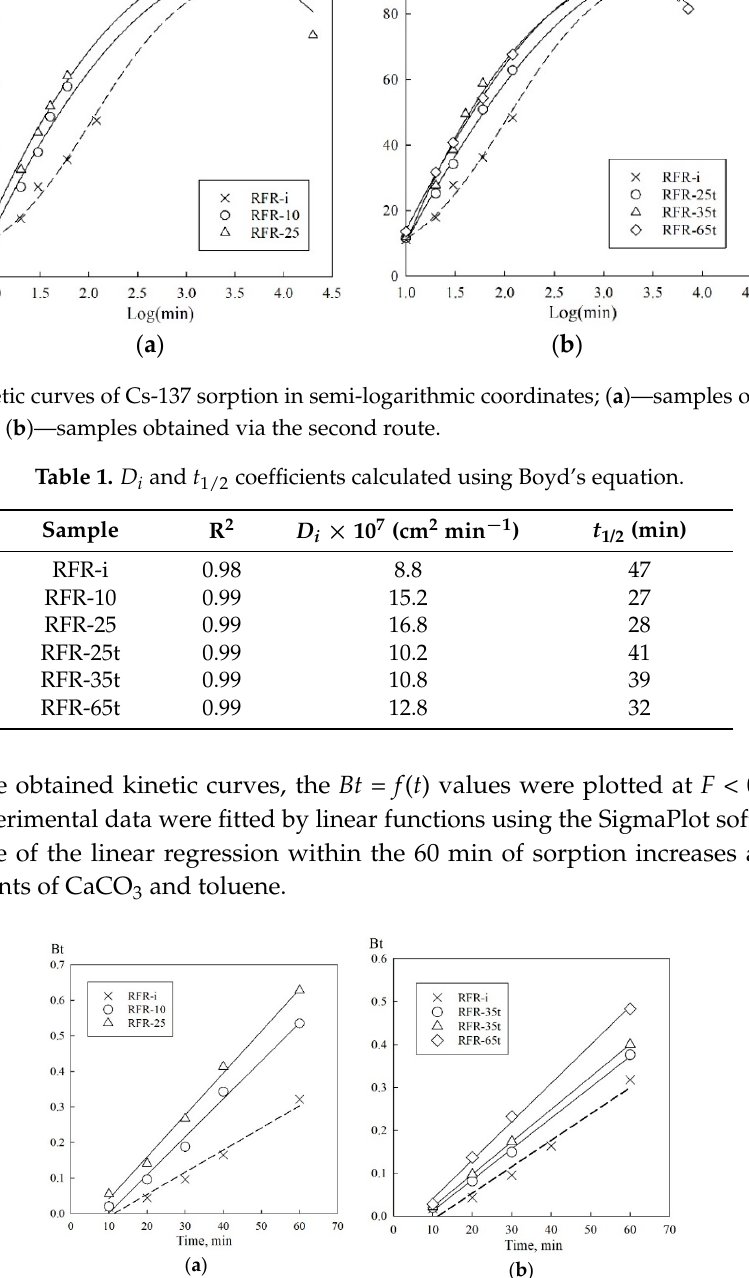
Figure 3. Bt = f ( t ) functions at F < 0.5; ( a )—samples obtained via the first route; ( b )—samples obtained via the second route. Table 1. D i and t 1/2 coefficients calculated using Boyd’s equation.